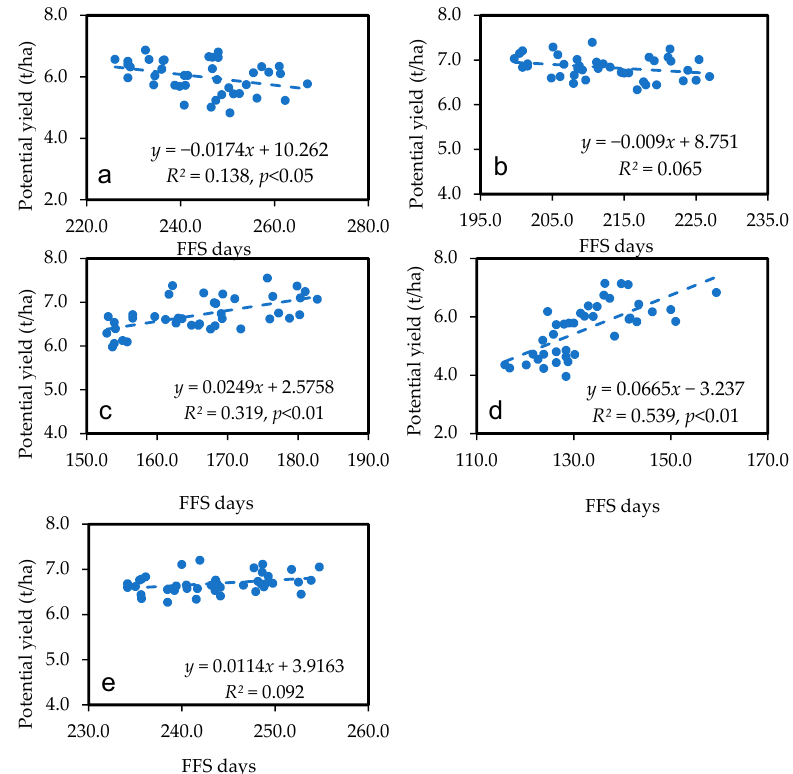
Figure 6. Correlation relationship between FFS and spring wheat potential yield in different altitude ranges on the QTP in the 1978–2017 period. ( a , b , c , d , e ) represent the altitude ranges of <2000, 2000– 3000, 3000–4000, >4000 m and the whole QTP, respectively.